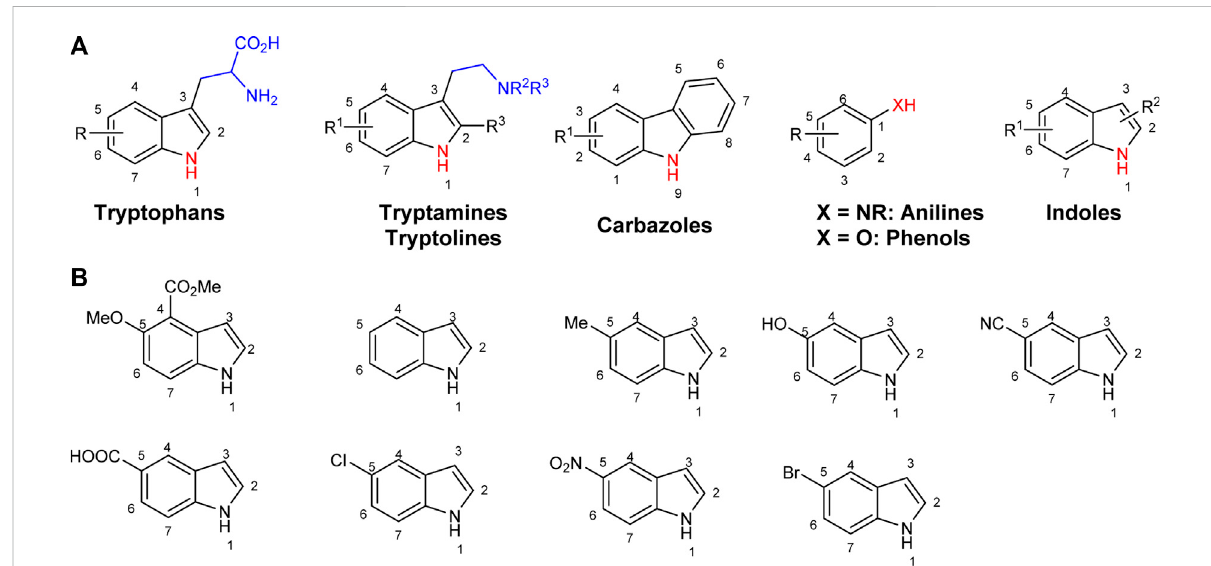
FIGURE 1 Arenes previously reported in halogenase studies; (A) Classes of compounds accepted by halogenases, (B) Indoles without a side chain at C2 and C3 as substrates for